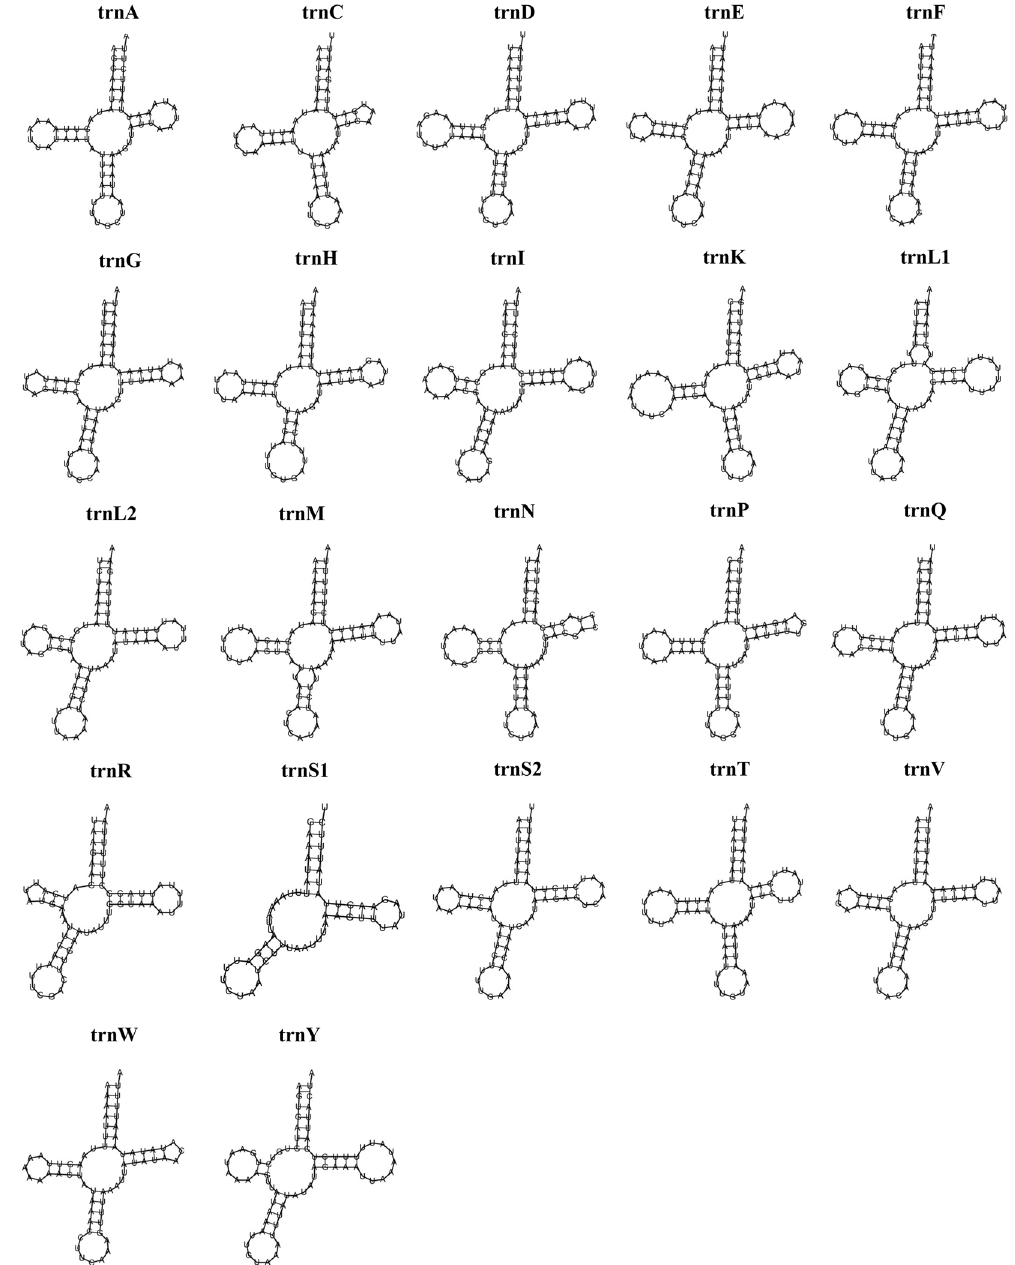
Figure 3. Predicted secondary structures of the 22 typical tRNA genes in the Anastatus fulloi